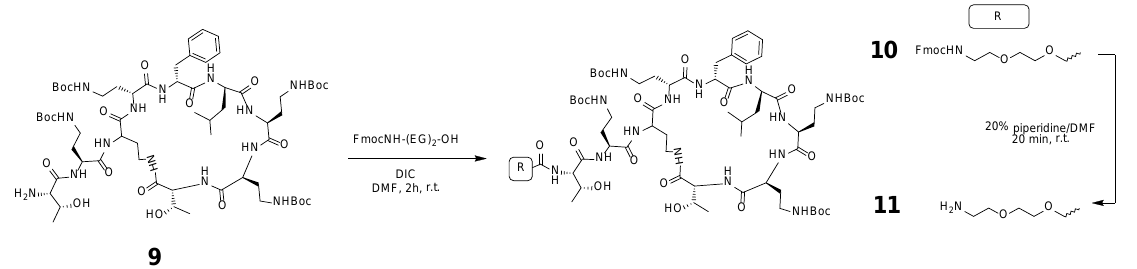
Scheme 1. Synthesis of H-(EG) 2 -PMX(Boc) 4 ( 11 ) from truncated PMX(Boc) 4 ( 9